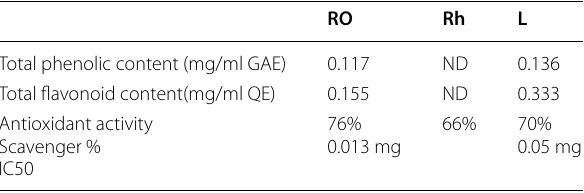
Table 1 Total phenolic and total flavonoid content RO, Rh and L crude alcoholic extract